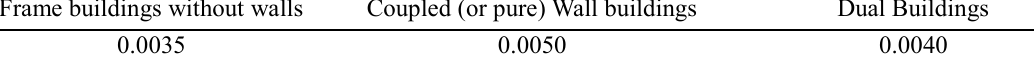
Fig. 1. Inelastic angular floor deformation 𝛾 axes used in the calculation of the enforced displacements 𝜓 Floor enforced-rotation 𝜓 order to predict the seismic demand of the flexible sides.